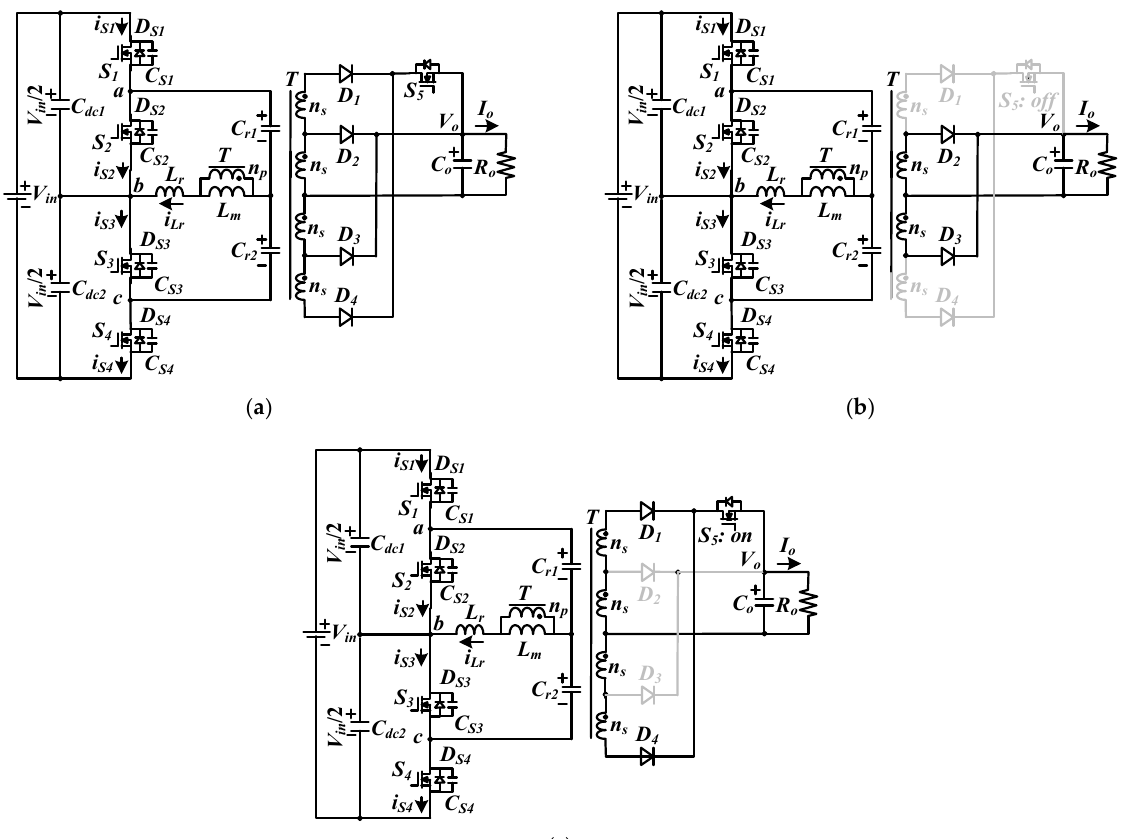
Figure 2. Circuit configuration of ( a ) presented DC/DC converter at ( b ) low voltage output and ( c ) high voltage output.